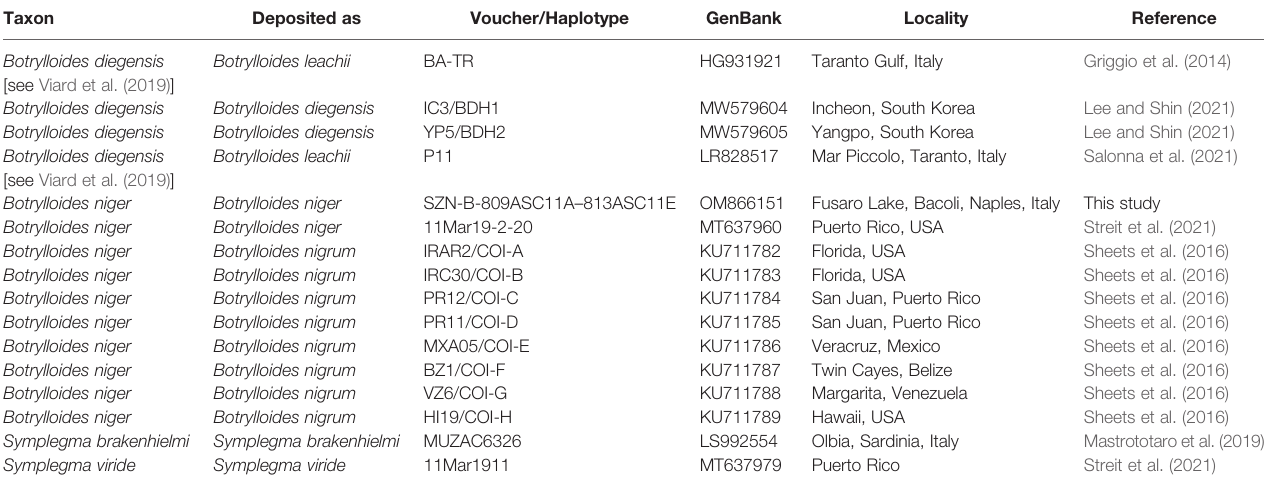
TABLE 1 | GenBank COI partial sequences of Botrylloides and Symplegma species used in the molecular analyses and associated accession numbers and voucher data (localities obtained from GenBank and/or relevant